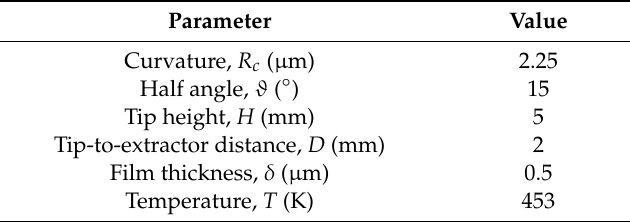
Figure 15. QuickSolver (ESPET) results for an indium wetted emitter needle compared to measurements by Tajmar [14]). Table 9. Parameters used to obtain QuickSolver results shown in Figure